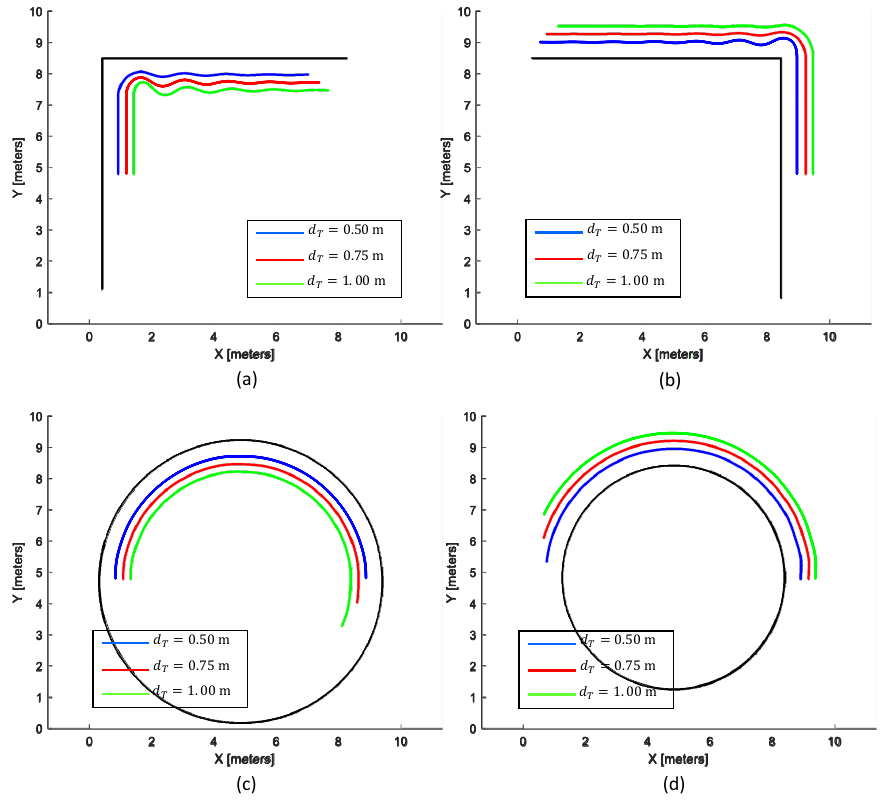
Figure 12. Wall-following behavior of the IT2-FLS with different settings of d T . ( a ) An inner wall segment of a right-angle corner. ( b ) An outer wall segment of a right-angle corner. ( c ) An inner surface of a curved wall. ( d ) An outer surface of a curved